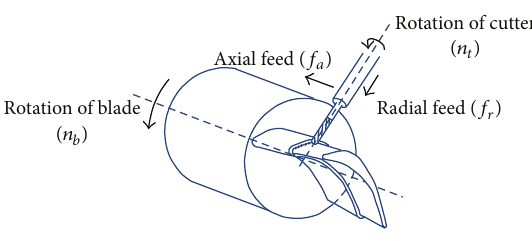
Figure 1: Turn-milling blade principle